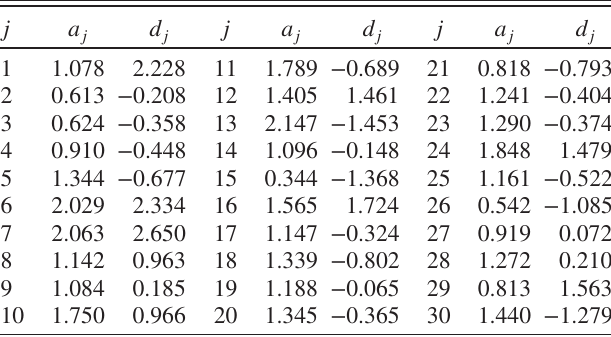
TABLE II. Fitting parameters for the single-trait model for all 30 items in the FCI